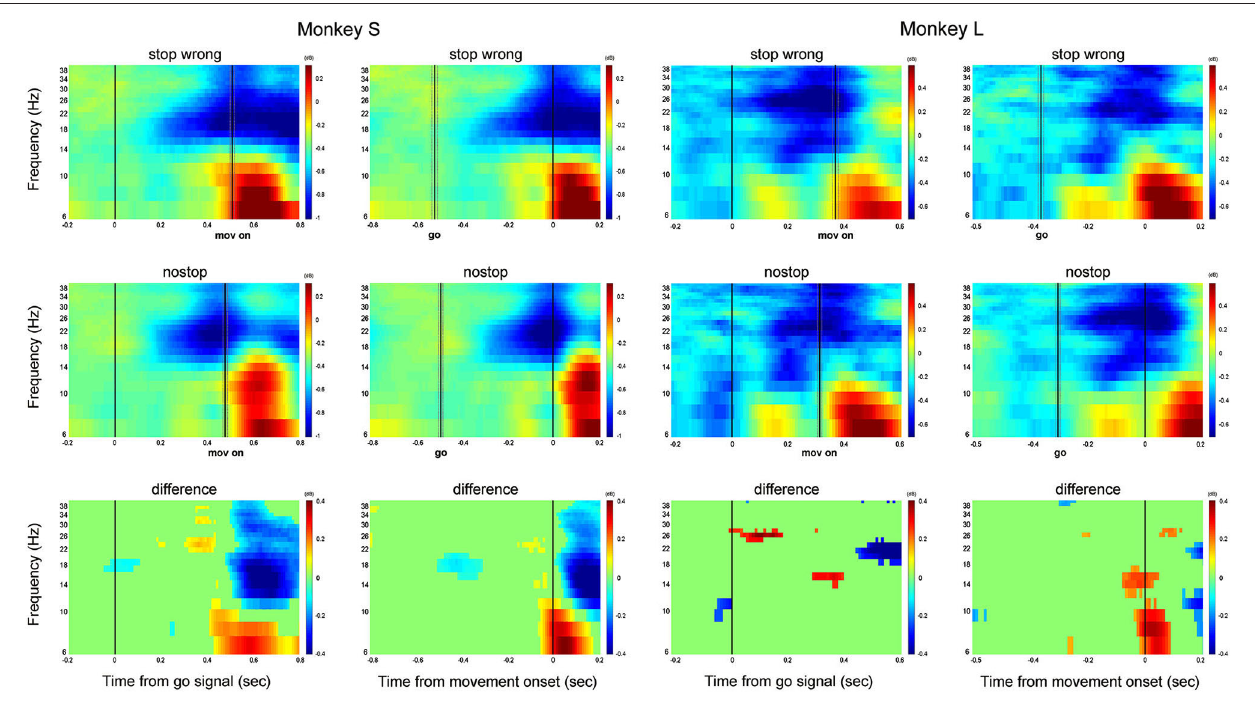
separately for each monkey. In left columns data are aligned to the go signal; in right colums are aligned to movement onset. Other conventions as in Figure 2 .